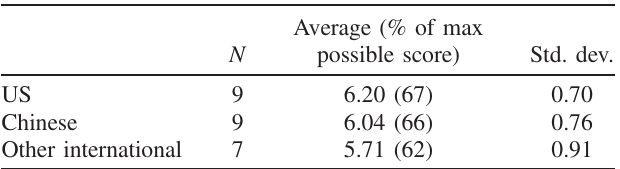
TABLE VI. Numbers of TAs of different backgrounds, their averages (and percentage of maximum possible score), and standard deviations (Std. dev.) for the scores obtained in determining introductory students ’ alternate conceptions on the FCI out of a maximum of